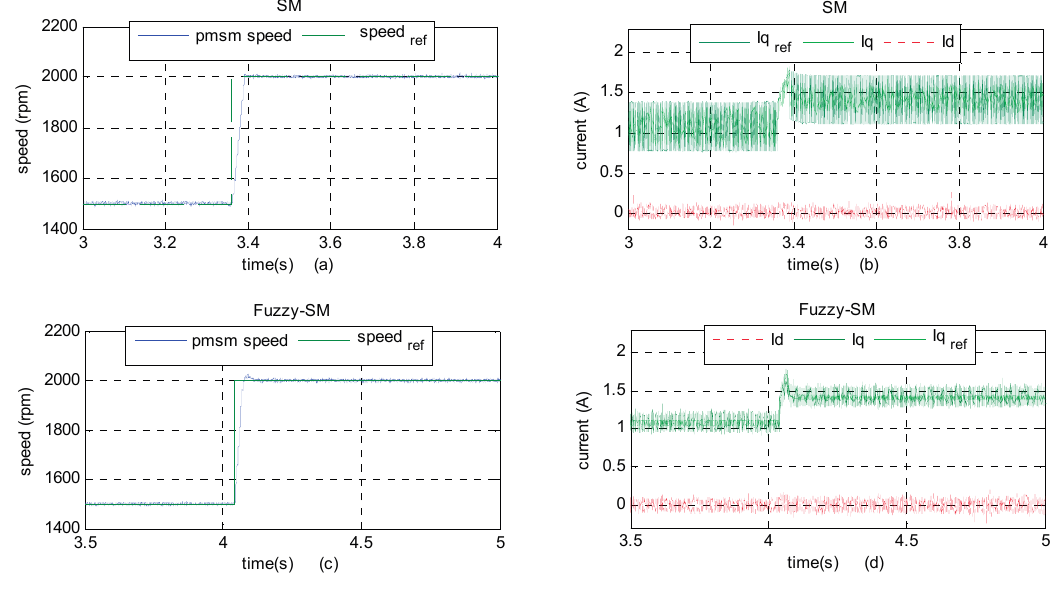
Figure 7. Experimental results of the proposed Fuzzy-SMC and SMC at the variation of speed. ( a ), ( c ), ( b ) and ( d ) speeds, I d and I q when SMC or Fuzzy-SMC is used respectively.